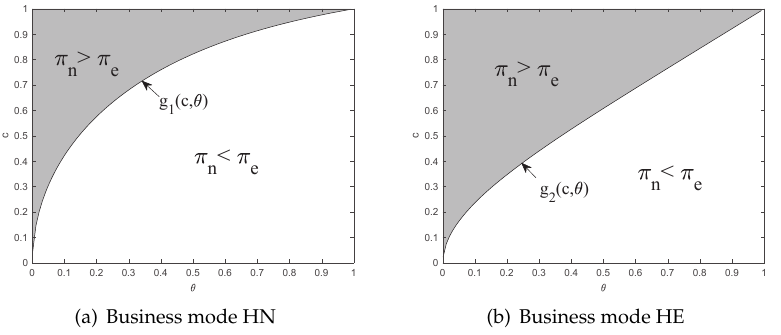
Figure 2. Profit comparison between the two brands under the hybrid business